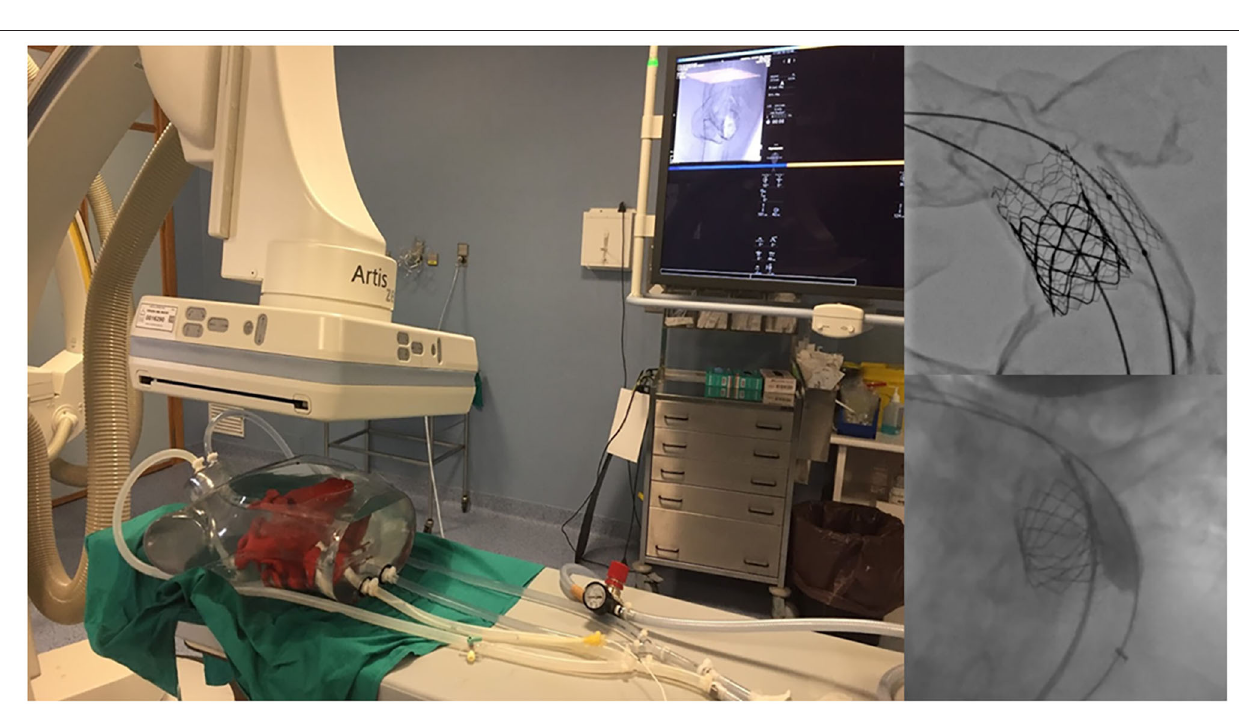
FIGURE 6 | Catheterization applications. Testing of the personalized catheterization simulator in real conditions. Two fluid inlets (superior and inferior cava vein) and two fluid outlets (aortic arch and descending aorta) (left). Percutaneous pulmonary valve implantation in a patient with severe right ventricle dilatation. Interventional planning with 3D printed model (up right) and real intervention in the patient (down